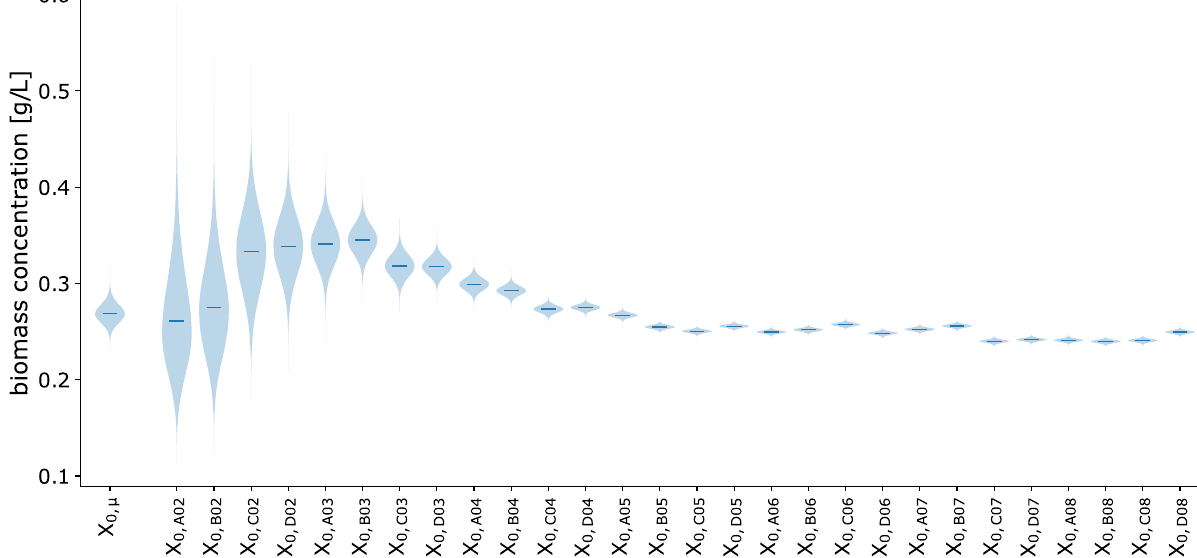
PLOS Computational Biology | https://doi.org/10.1371/journal.pcbi.1009223 March 7,